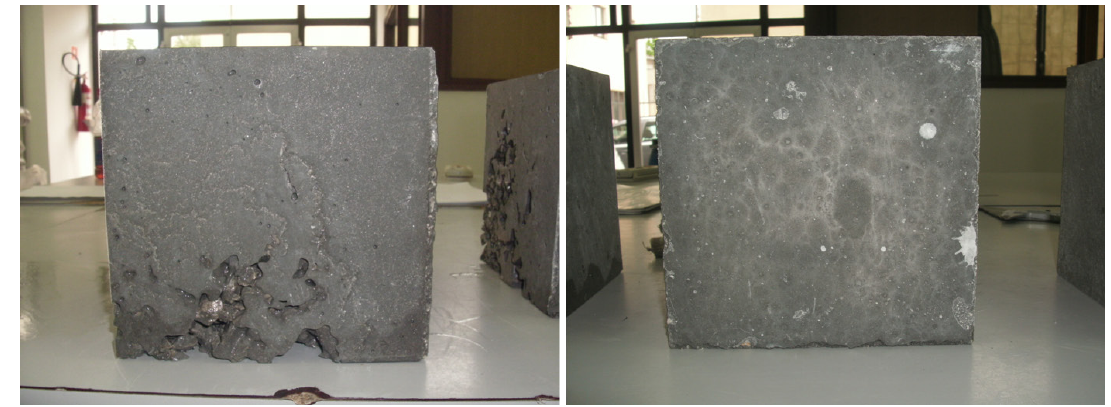
Figure 10. The appearance of the surface of MSCC (left) and VSCC (right).